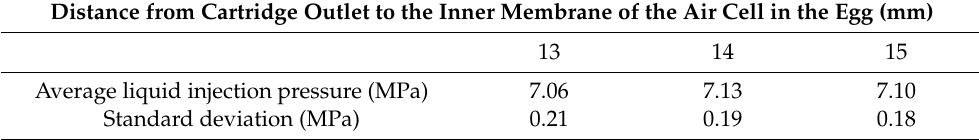
Table 2. Variation in the liquid jet pressure of ~7 MPa at different